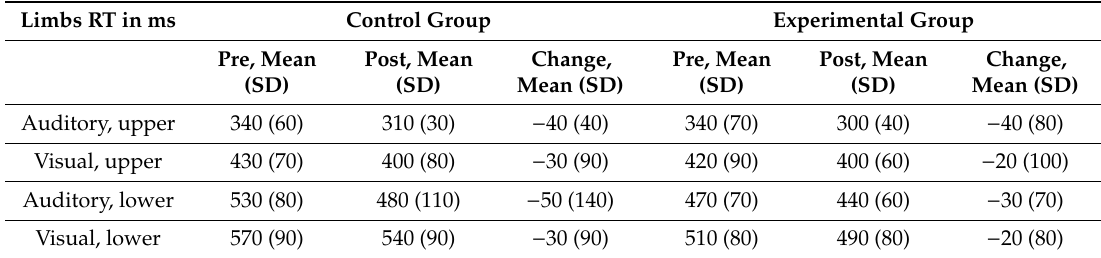
Table 1. Reaction times (RT) to auditory and visual stimuli for the upper and lower limbs pre- and post- VO / MI training in the control and experimental groups.